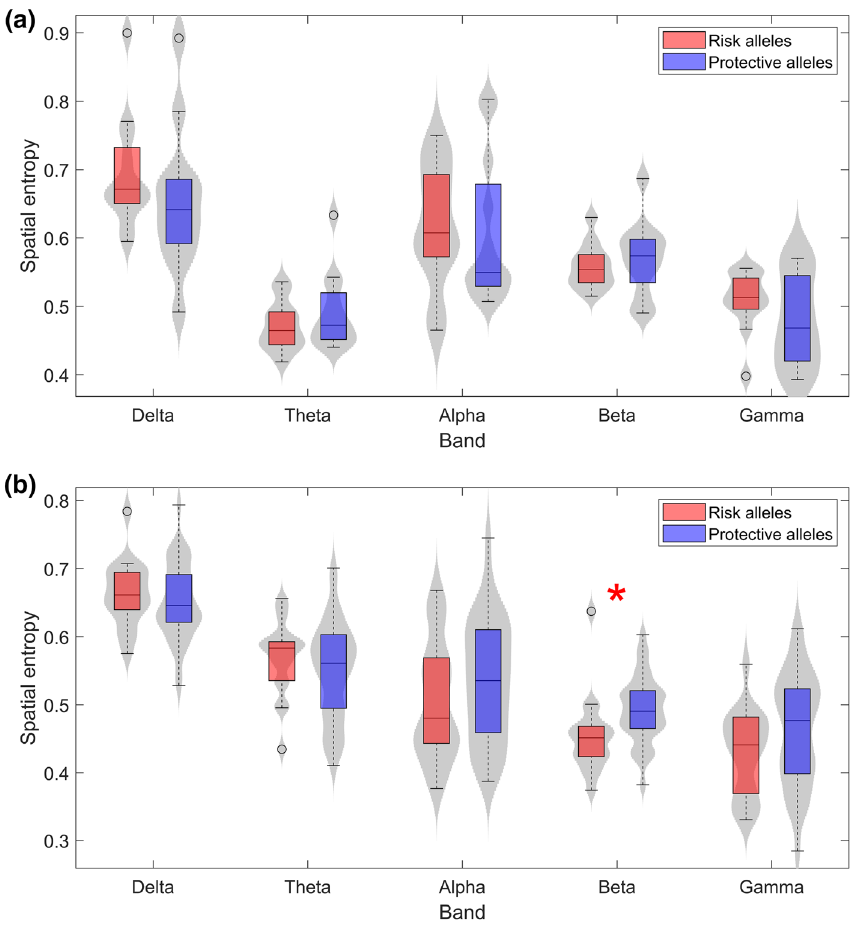
Figure 3. Spatial entropy of RP values for ( a ) controls and ( b ) AD patients in each frequency band. Subjects with risk alleles for both PICALM and CLU are represented in red, whereas subjects with both protective alleles are displayed in blue. Statistically significant differences ( p -value < 0.05, Mann–Whitney U -test) are highlighted with a red